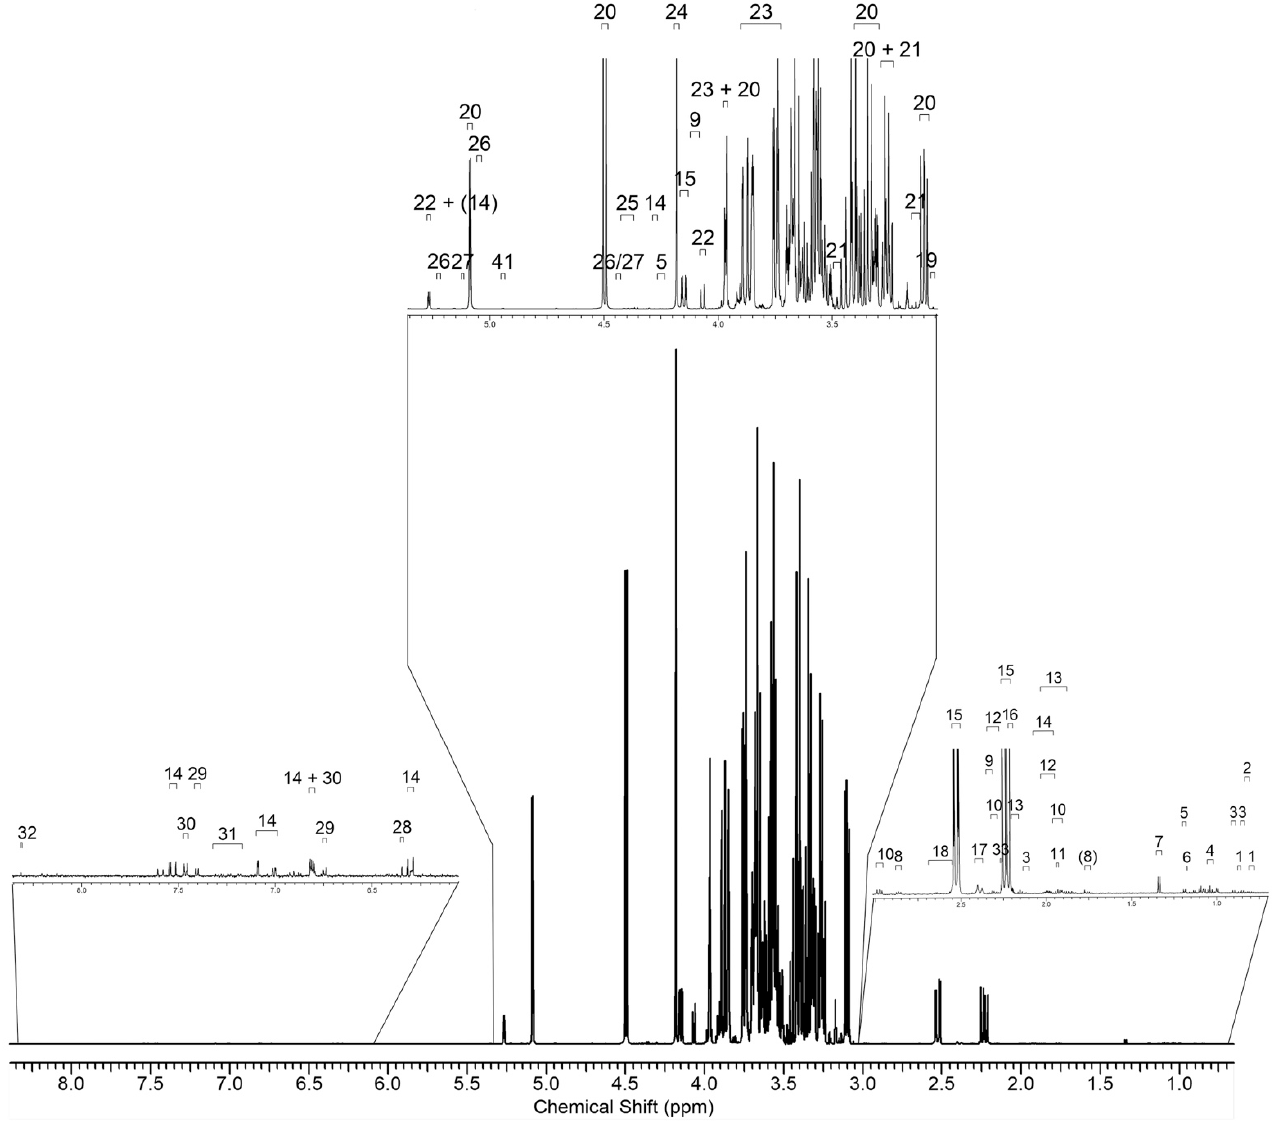
Figure 9. Representative 1 H ‐ nuclear magnetic resonance (NMR) spectrum of Vitis vinifera berry extract in D 2 O phosphate buffer, pH 6.86. Three portions of the spectrum were magnified to show resonances that have been assigned and labeled (1, isoleucine; 2, leucine; 3, valine; 4, ethanol; 5, threonine; 6, lactic acid; 7, alanine; 8, lysine; 9 proline; 10, GABA; 11, acetic acid; 12, glutamine; 13, glutamic acid; 14, chlorogenic acid; 15, malic acid; 16, acetoacetic acid; 17, citric acid; 18, aspartic acid; 19, malonic acid; 20, glucose; 21, myo ‐ inositol; 22, sucrose; 23, fructose; 24, tartaric acid; 25, DHA; 26, xylose; 27, galactose; 28, fumaric acid; 29, vanillic acid; 30, tyrosine; 31, phenylalanine; 32, formic acid).